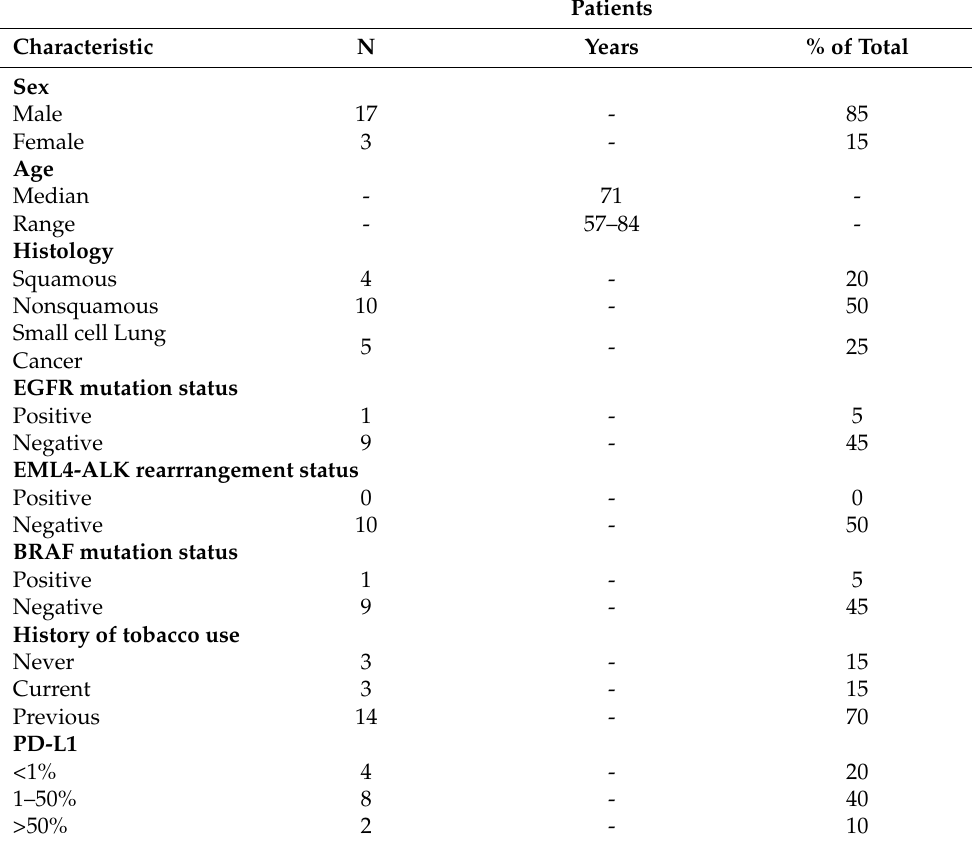
Table 1. Patients and disease